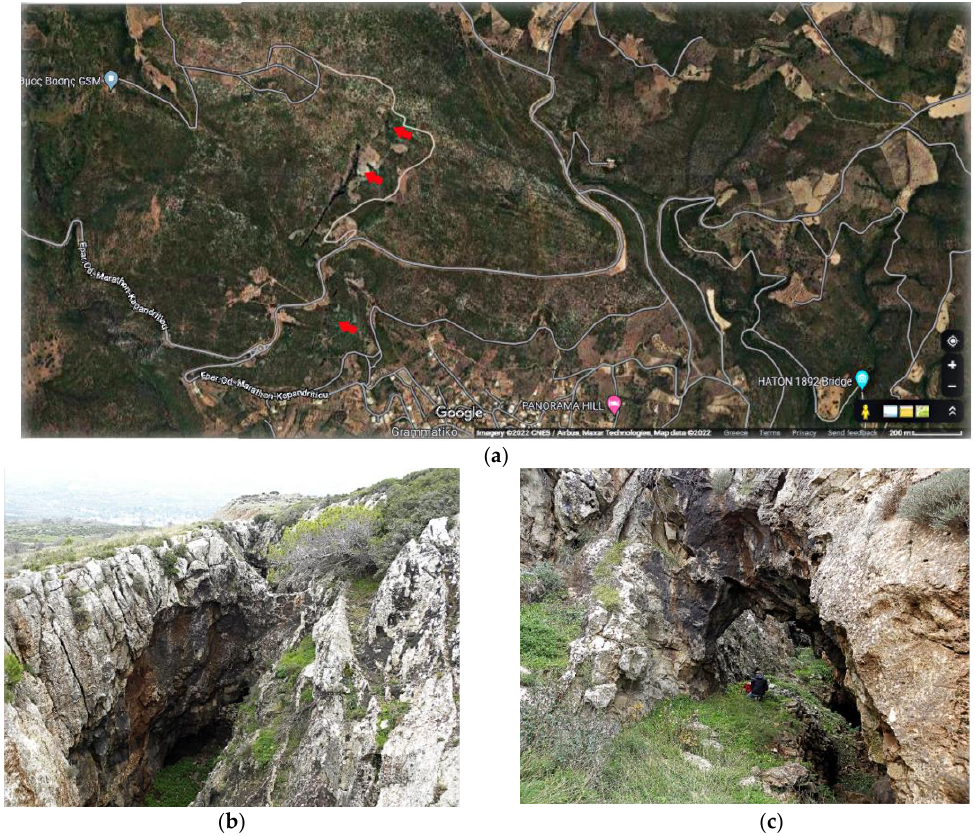
Figure 2. ( a ): Aerial view of the Grammatiko mines (Google Map) showing the positions of the Figure 2. ( a ) Aerial view of the Grammatiko mines (Google Map) showing the positions of the trenches (red arrows). ( b , c ): Fe-Mn mineralization is hosted within brecciated and foliation zones of trenches (red arrows). ( b , c ) Fe-Mn mineralization is hosted within brecciated and foliation zones of carbonate rocks, ranging in thinness from a few millimeters to a few meters, in ancient mines of Grammatiko